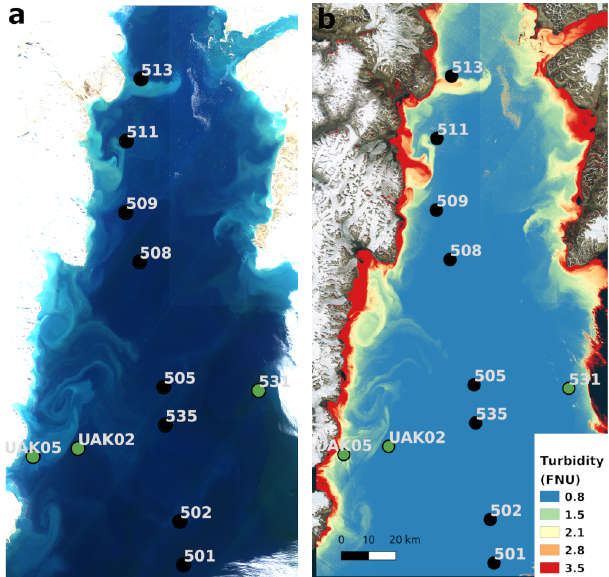
Figure 3. Satellite products derived from a Sentinel-2 acquisition on 22 June 2020: (a) false colour composite of the red (665nm), green (560nm), and blue (492nm) channels of the bottom-of-the- atmosphere (BOA) reflectance, with values shown between 0–0.07, (b) turbidity map derived from the BOA reflectance with the land part for illustration (Bing aerial image © Microsoft). The position of the sampling stations is indicated in black (south–north transect) and green (east to west transect). Figure 4. Section plots of (a) practical salinity, (b) temperature with